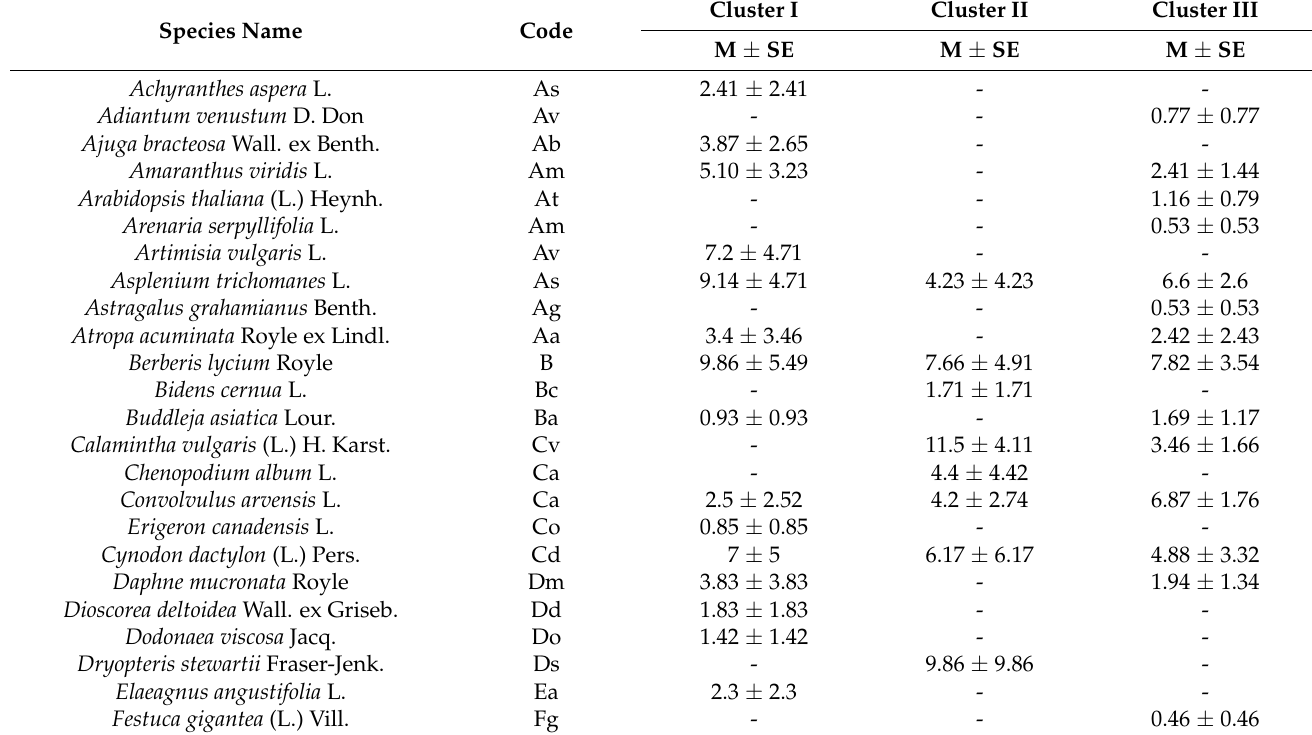
Figure 4. Cluster dendrogram classifying understory vegetation into three distinct groups. Note: G (Group); St (Stand). Table 2. Understory flora associated with oak-dominated forest recorded in the three clusters separated by Ward’s agglomerative clustering procedure.